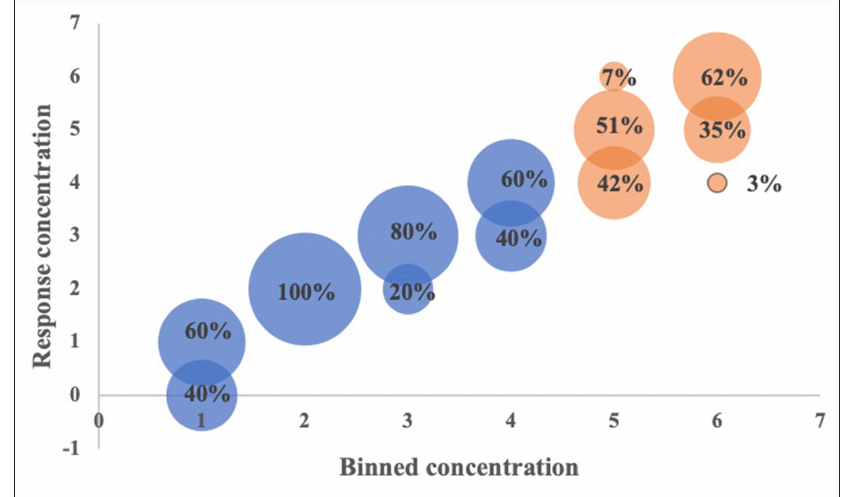
Figure 4 The relationship between nitrate concentrations and corresponding response categories produced by visual volunteers. The blue color corresponds to the samples in the lower range with smaller residuals and the orange corresponds to the samples in the higher range with residuals across three categories. The size of the circles provides a visual approximation of the proportion of samples that fall within each response concentration. In each case the total proportion equals 100%. The response concentration categories are defined by Hach as: 0 = 0ppm, 1 = 1ppm, 2 = 2ppm, 3 = 5 ppm, 4 = 10 ppm, 5 = 20 ppm, and 6 = 50